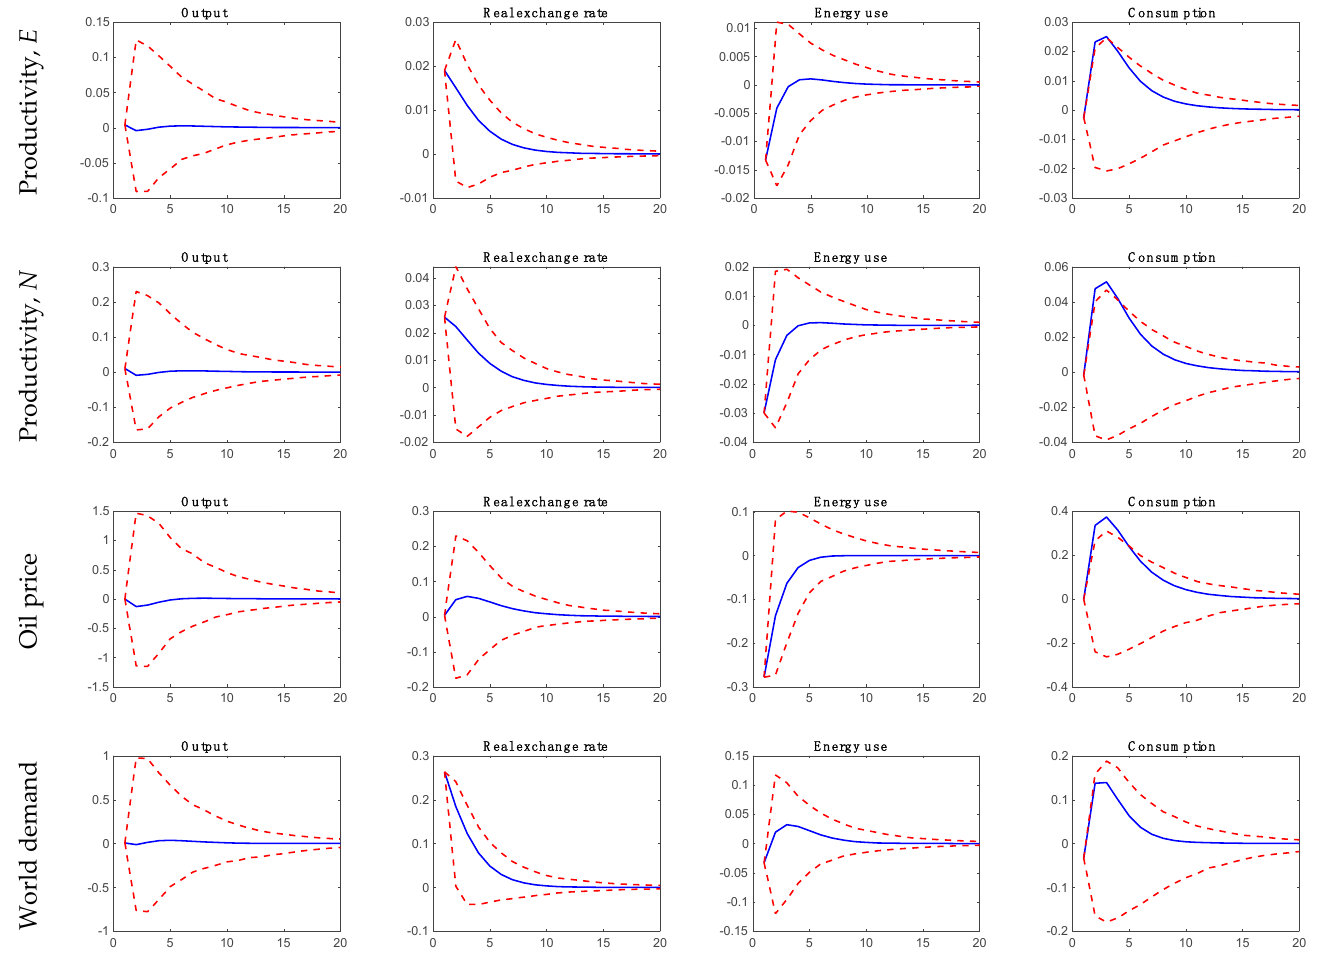
Figure 4. VAR impulse response functions. Note : blue solid lines: estimated impulse response function; red dashed lines: 95% confidence intervals.